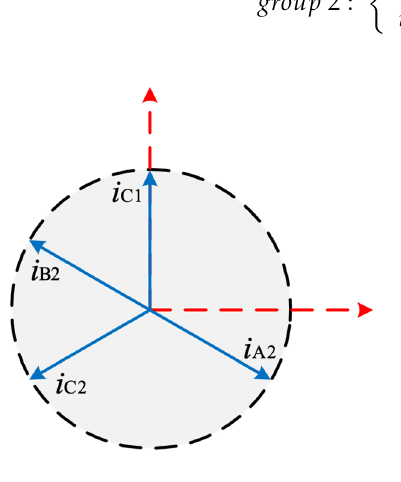
Figure 16. Phase diagram of regulated currents under two-phase open-circuit (Case III: phase A1 and B1 open-circuit) fault-tolerant control.